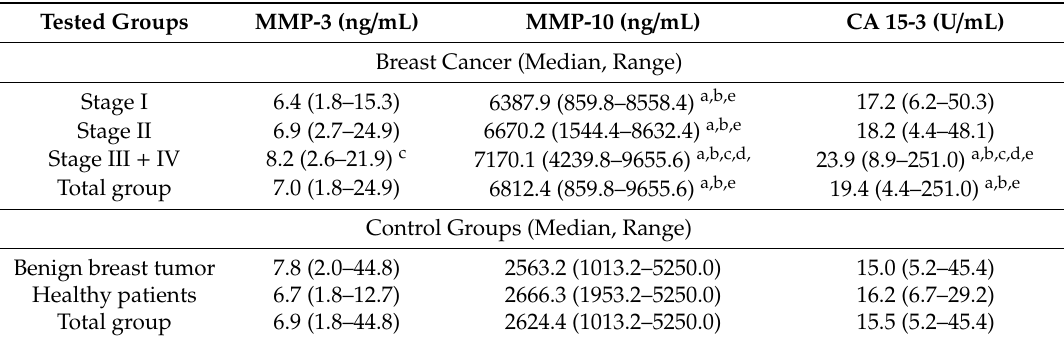
Table 2. Plasma levels of tested parameters in patients with BC and control